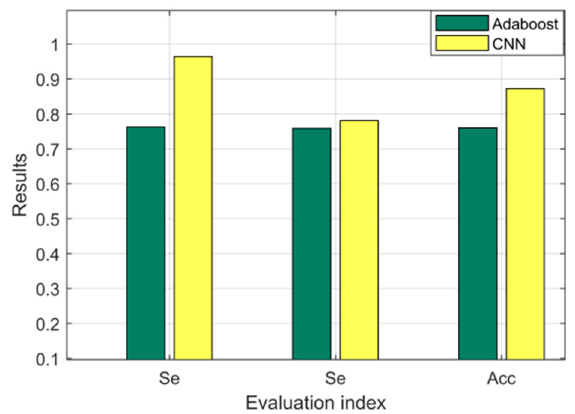
Figure 12. The results under Adaboost classifier and CNN classifier.